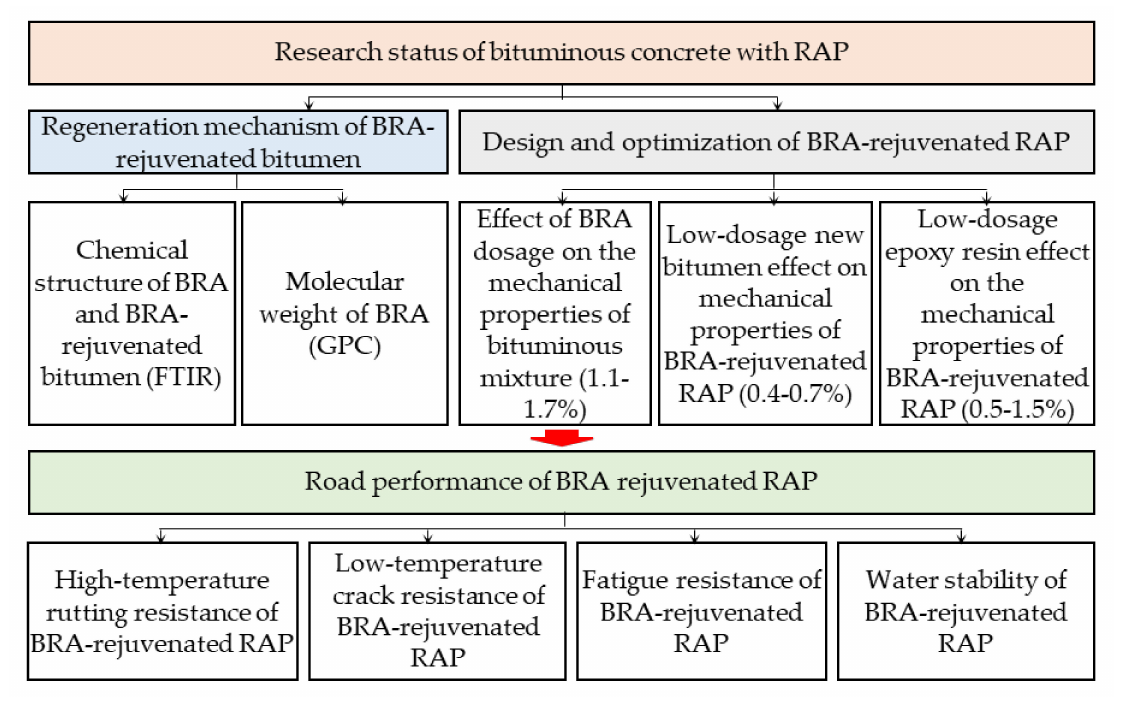
Figure 1. Technical map. (Where, BRA: Bio-rejuvenated additive; RAP: Reclaimed bituminous mixture; GPC: gel permeation chromatography; FTIR: Fourier transform infrared